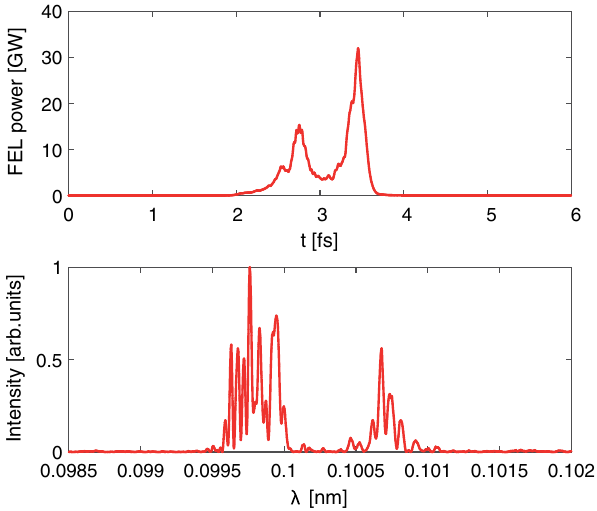
FIG. 10. Power of the emitted radiation as a function of time (top) and corresponding FEL spectra (bottom) for two pulses with a time delay smaller than 1